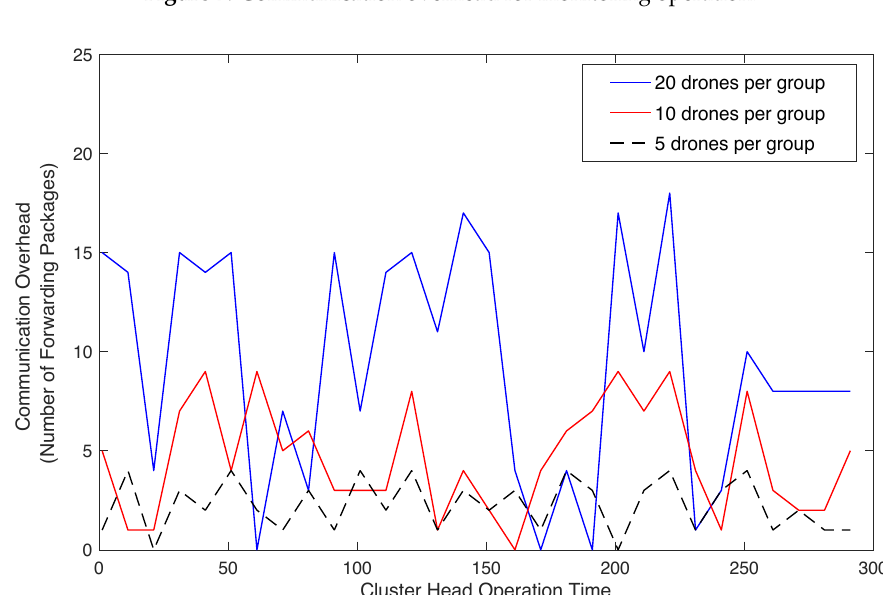
Figure 7. Communication overhead for monitoring operation.